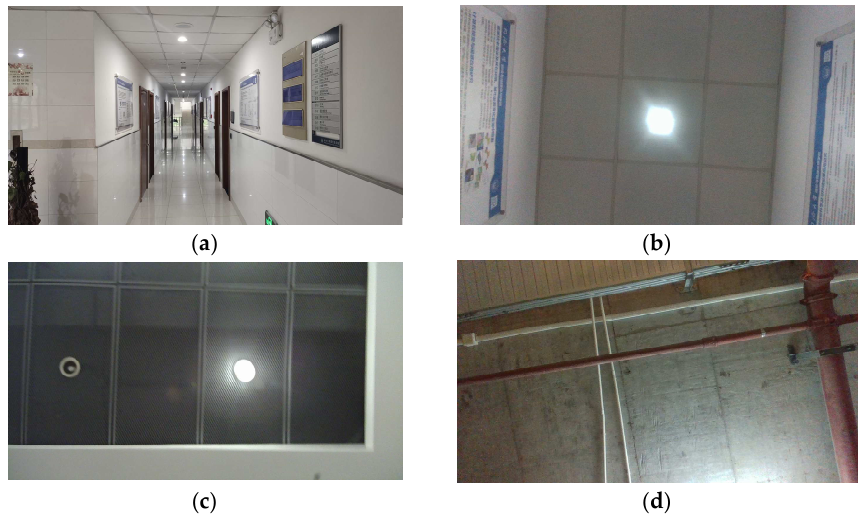
Figure 9. ( a ) The overall scene of the indoor corridor in the ceiling dataset. ( b ) The grid ceiling image of the corridor in sequence 1 and sequence 2. ( c ) The lobby ceiling image in sequence 3 and sequence 4. ( d ) The underground parking lot ceiling image in sequence 5 and sequence 6.